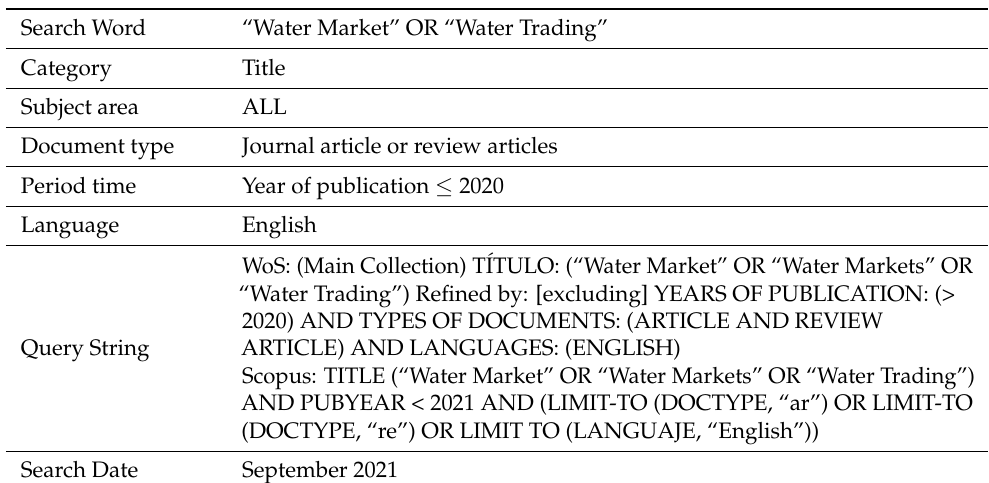
Table 1. Characteristics of the document